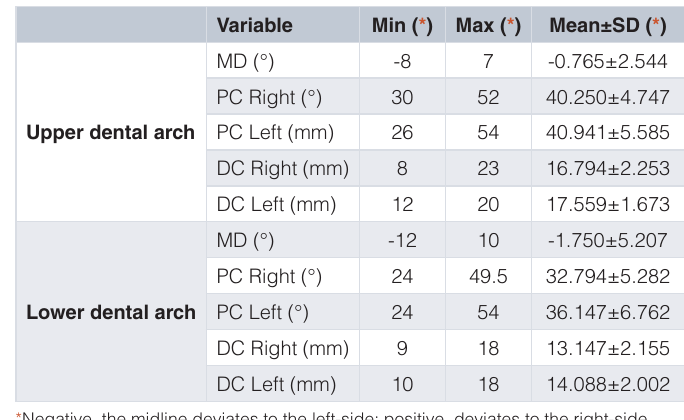
Table 1. Distribution of upper and lower dental arch symmetry in condylar hyperplasia patients.